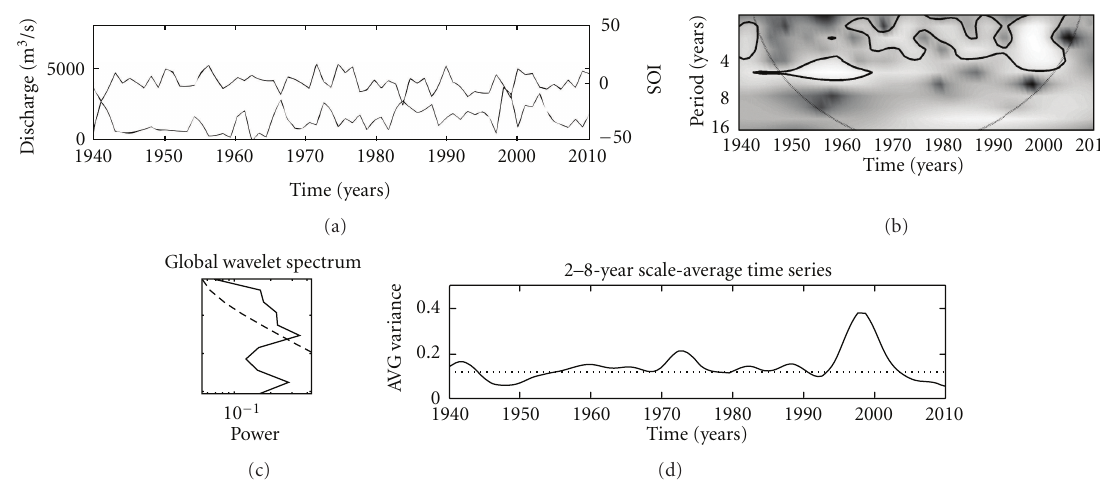
Figure 6: Freshwater discharge and SOI series (a). Cross-wavelet power between freshwater discharge and SOI; the dotted line indicates the cone of influence (b). Global wavelet spectrum between freshwater and SOI (c) and the average variance on scales between 2 and 8 years (d).